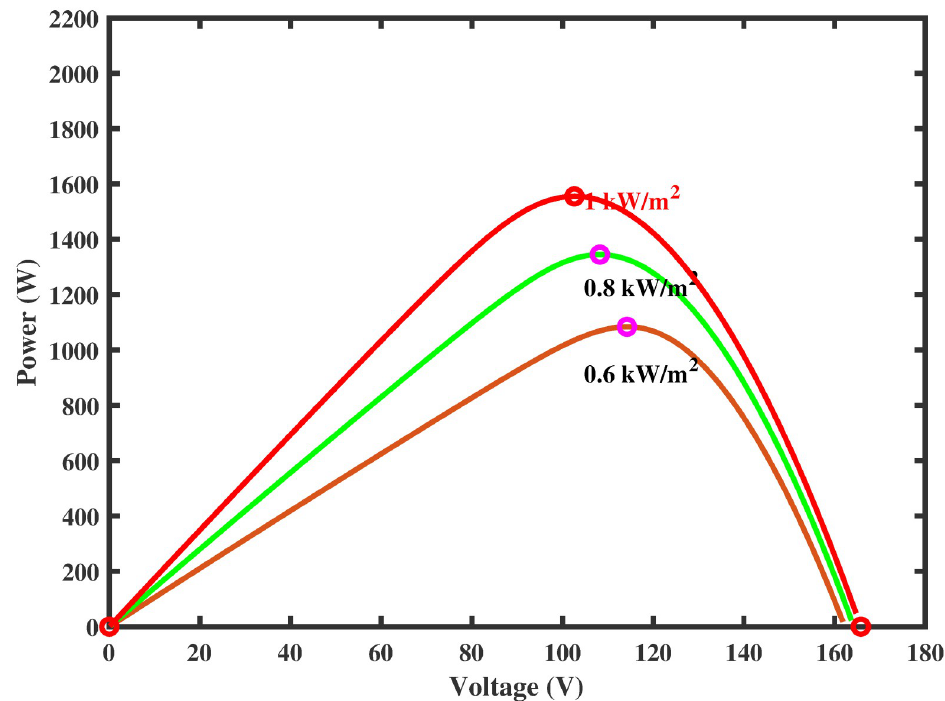
Fig 1. Power characteristic curve under varying